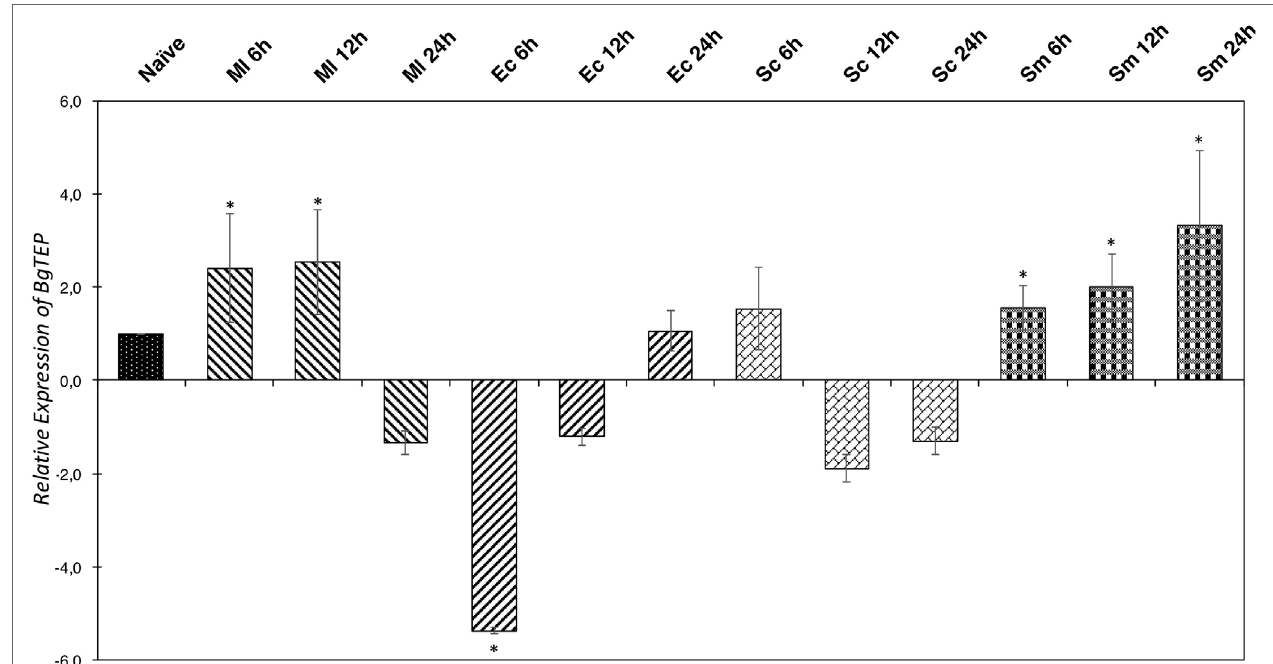
FigUre 5 | Immune-inducible transcription of BgTEP. Quantitative RT-PCR was performed from whole snails exposed to different immune challenges or unexposed. BgTEP expression was monitored at three time points (6, 12, and 24 h) post-challenge with Micrococcus luteus (decreasing hatching), Escherichia coli (increasing hatching), Saccharomyces cerevisiae (rectangle), and Schistosoma mansoni (square). BgTEP expression was normalized by S19 housekeeping gene expression for each experimental point and compared with the relative expression obtained in non-exposed snails. Error bars represent the SD of the relative quantification values obtained for each kinetic point. The significant difference in BgTEP expression was evaluated according to a Kruskal–Wallis test followed by a Dunn’s post hoc test. The asterisks indicate a significant difference between non-exposed and exposed